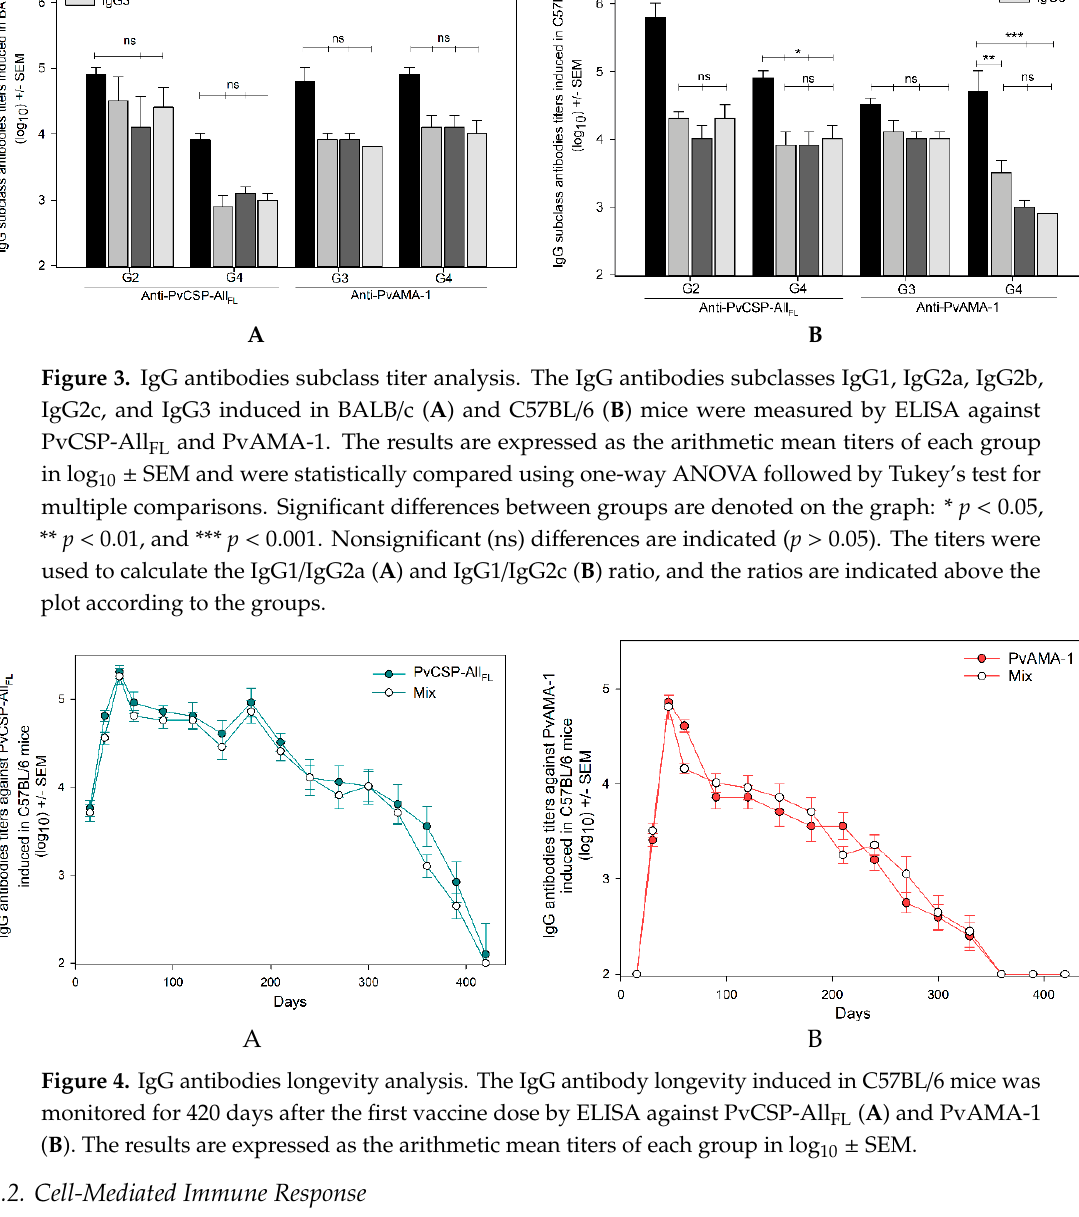
Figure 4. IgG antibodies longevity analysis. The IgG antibody longevity induced in C57BL/6 mice was monitored for 420 days after the first vaccine dose by ELISA against PvCSP-All FL ( A ) and PvAMA-1 ( B ). The results are expressed as the arithmetic mean titers of each group in log 10 ± SEM.